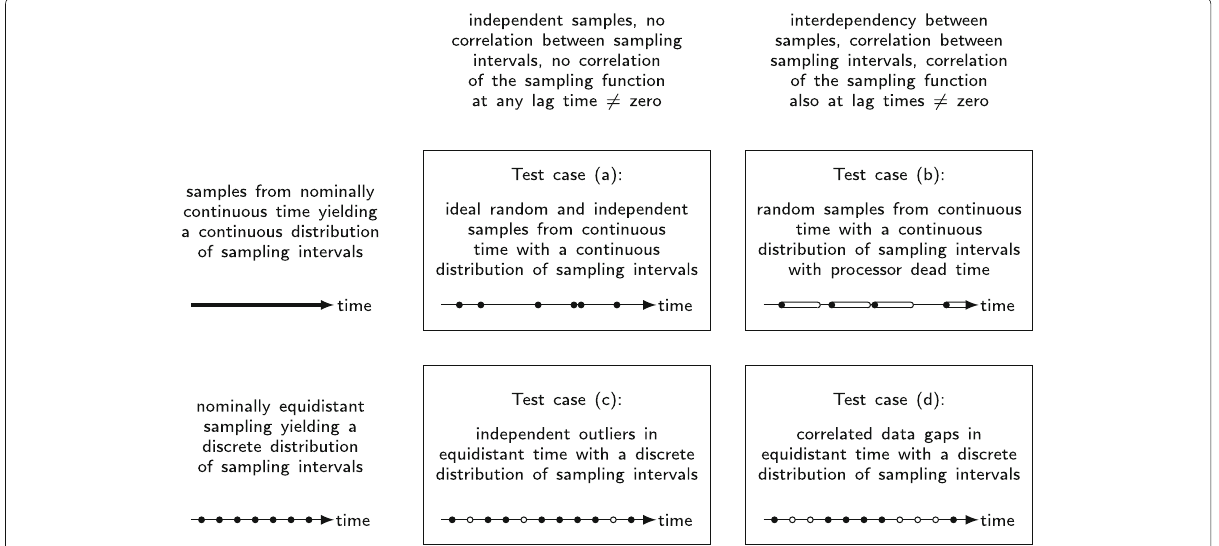
Fig. 2 Illustration of the four test cases of irregular sampling (valid samples denoted by black dots, invalid samples denoted by white dots, times with forbidden sampling denoted by elongated white spaces in